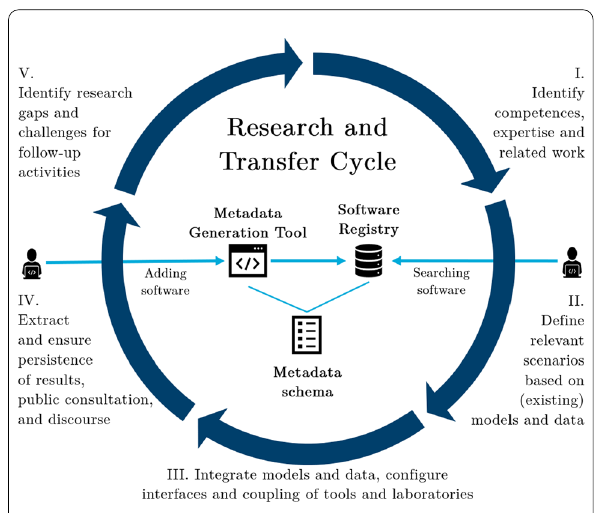
Fig. 1 A metadata‑based registry within a typically research cycle of energy research Different approaches to formulate the FAIR criteria for research soft- ware show that metadata and repositories for these metadata,